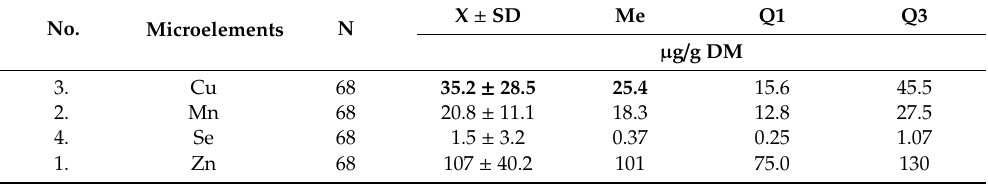
Table 2. Average and median content of Cu, Mn, Se and Zn in the studied mushrooms ( µ g / g DM). No.